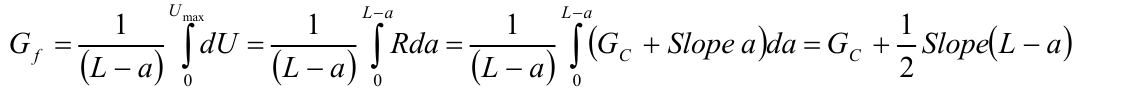
, slope of rising R-curve from Matsumoto and Nairn (1) [10] C predicted according to Equation 2 for a ligament length of f